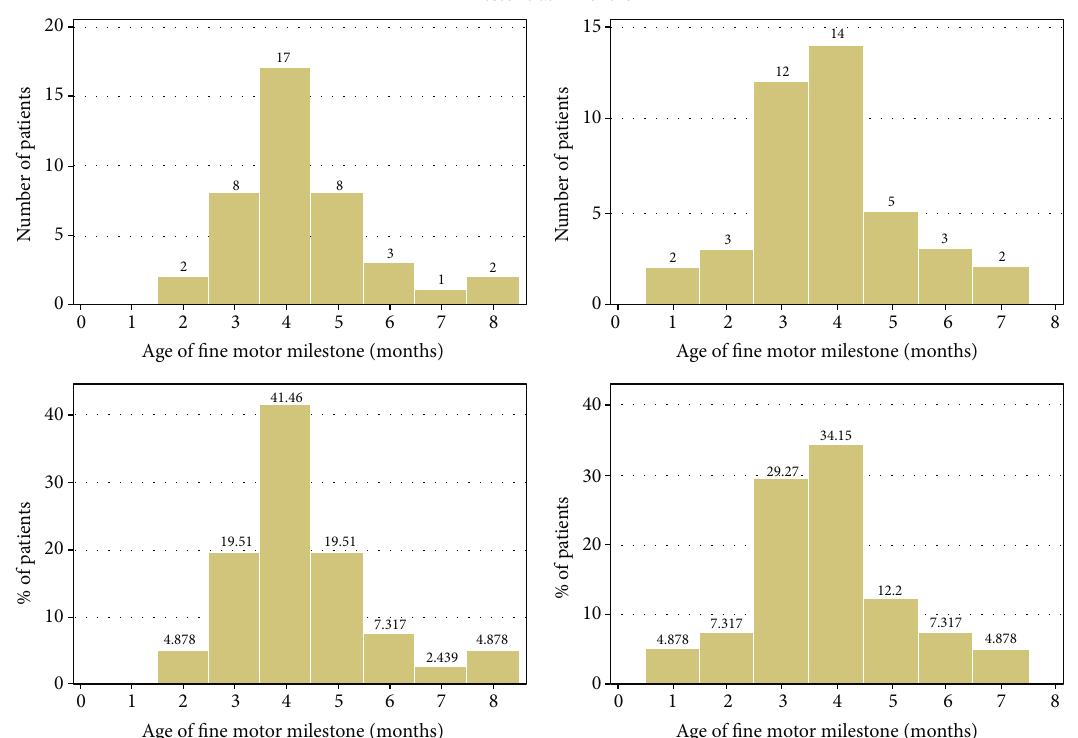
Figure 4: Patients treated with propranolol compared to expected developmental milestone. Number of patients per age that achieved 4- month milestone and percentage of patients per age that achieved 4-month